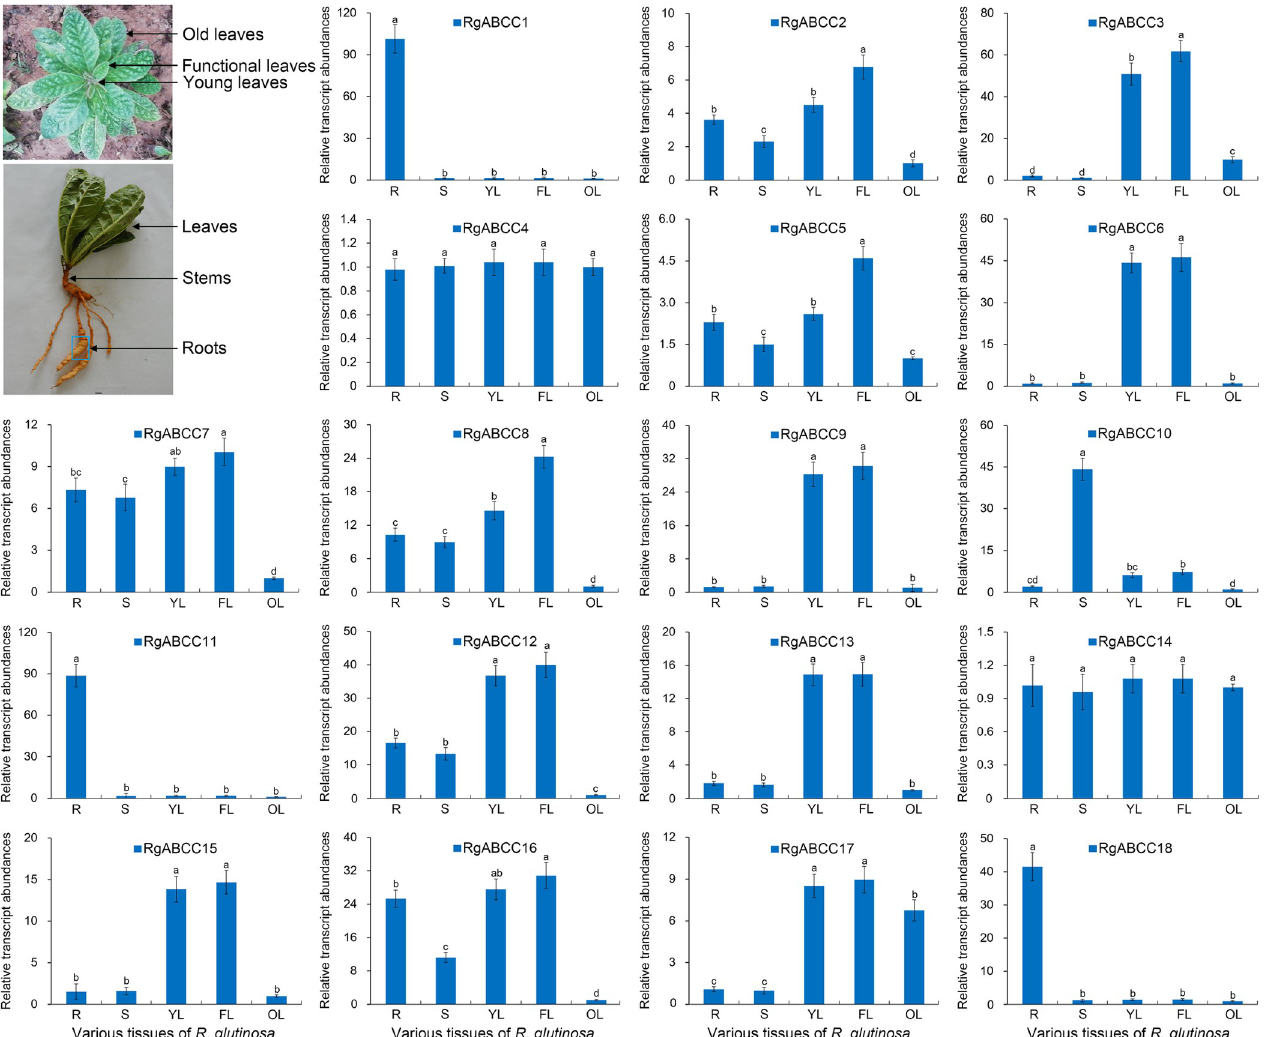
Fig 4. Transcript profiles of the RgABCCs in various tissues. Note: “R, S, YL, FL and OL” represent “roots, stems, young, functional and old leaves, respectively; errors bars are standard deviation (SD), the same below.